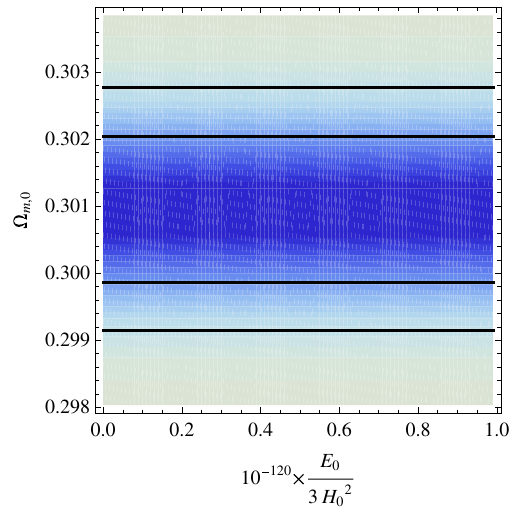
Fig. 14 The intersection of the likelihood function of two model parameters( (cid:5) m , 0 , E 0 ),withthemarked68and95%confidencelevels. 3 H 2 0 Theplaneoftheintersectionisthebestfitof H 0 ( H 0 = 68 . 82